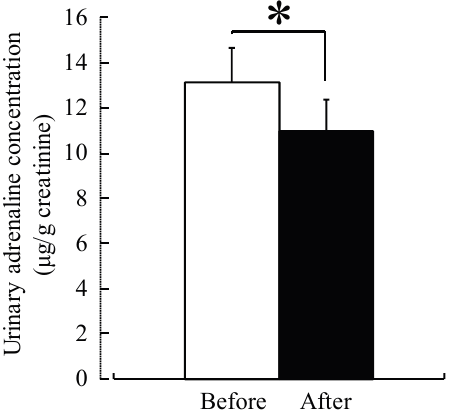
Figure 2. Effect of forest therapy on systolic and diastolic blood pressures in middle-aged males with high-normal blood pressure. N = 9, mean ± standard error. ** p < 0.01, paired t -test.